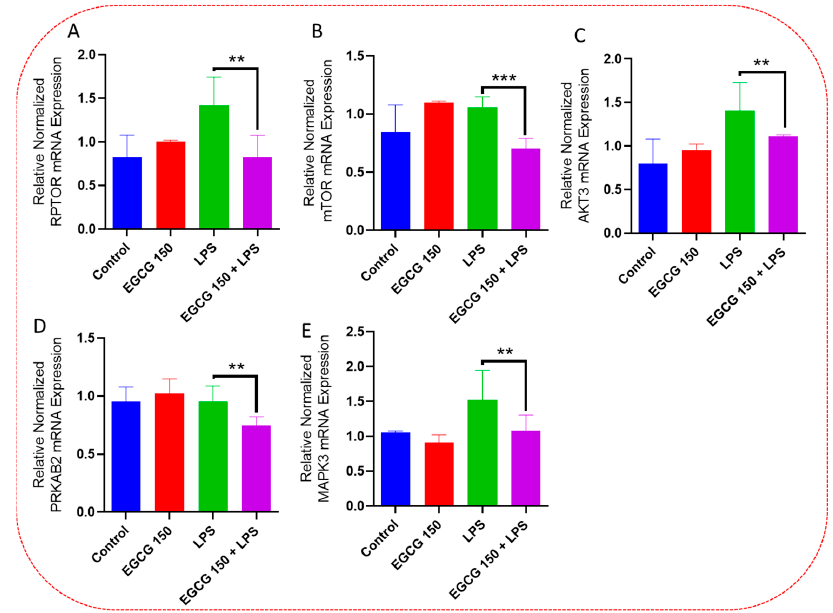
Figure 11. EGCG downregulated inflammatory microglial mTOR Genes. PCR array examination showed that EGCG 150 µM paired with LPS (1 µg/mL) reduced mRNA expression of the genes RPTOR ( A ), Mtor ( B ), AKT3 ( C ), PRKAB2 ( D ), and MAPK3 ( E ) compared to LPS. Values represent the mean ± SD, ** p ≤ 0.01, and *** p ≤ 0.001 vs. LPS.